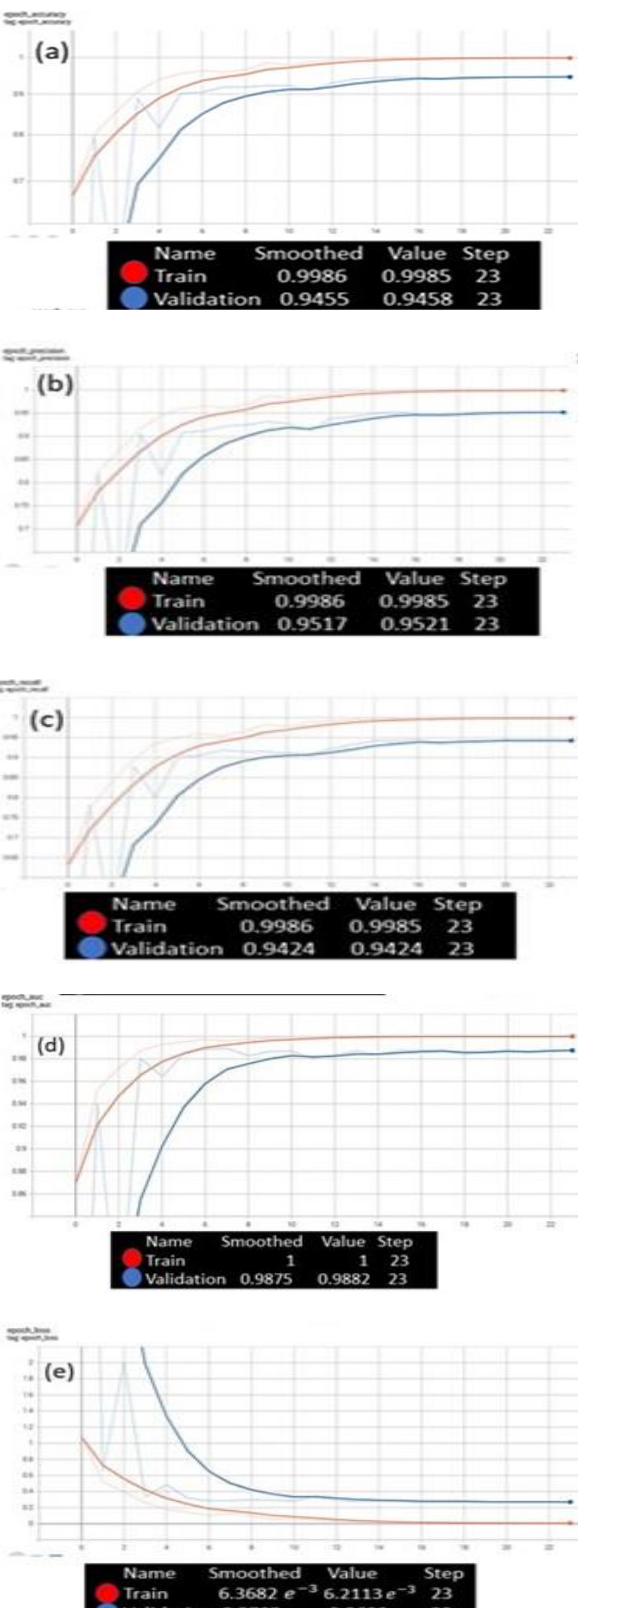
Fig. 6. Graphical representation of performance metrics: (a) Accuracy, (b) Precision, (c) Recall, (d) Area under the curve and (e) Categorical cross entropy loss